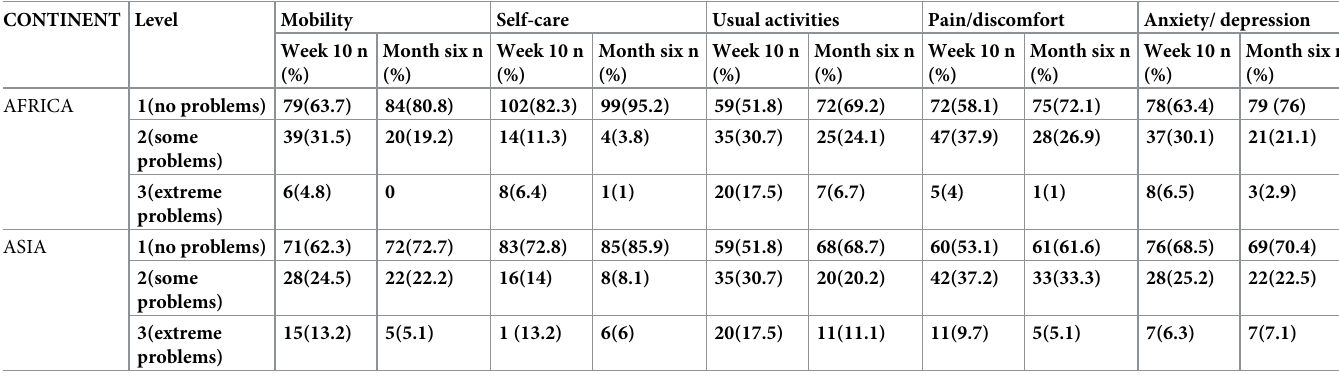
Table 2. Health profile scores for patients at week 10 and month